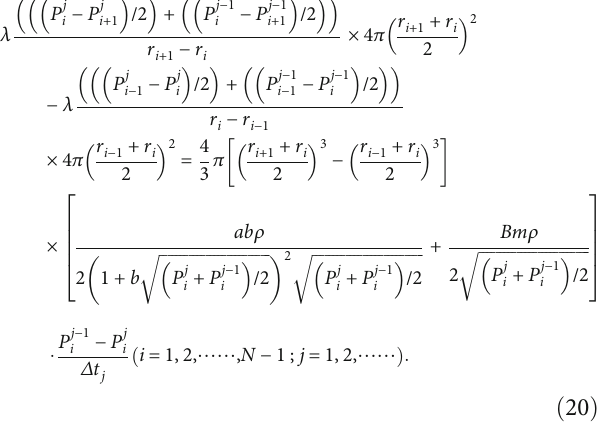
ffiffiffiffiffiffiffiffiffiffiffiffiffiffiffiffiffiffiffiffiffiffiffiffiffiffiffi (cid:6) 2 ffiffiffiffiffiffiffiffiffiffiffiffiffiffiffiffiffiffiffiffiffiffiffiffiffiffiffi